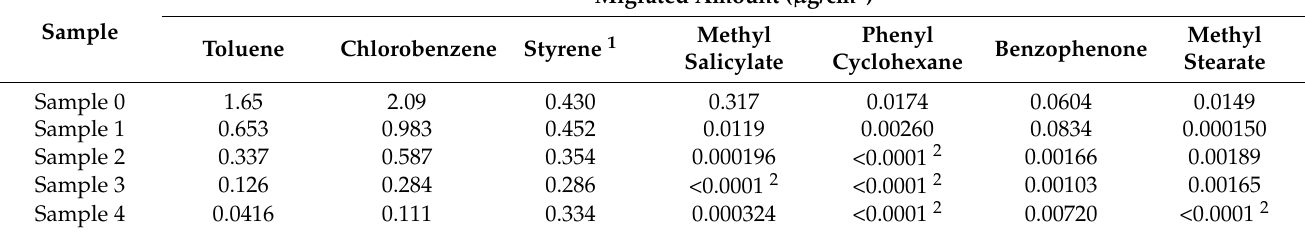
Table 3. Experimentally determined migrated amounts of the surrogates and styrene into the gas phase from yogurt cups after storage for 10 days at 60 ◦ C (pre-storage time for all samples seven